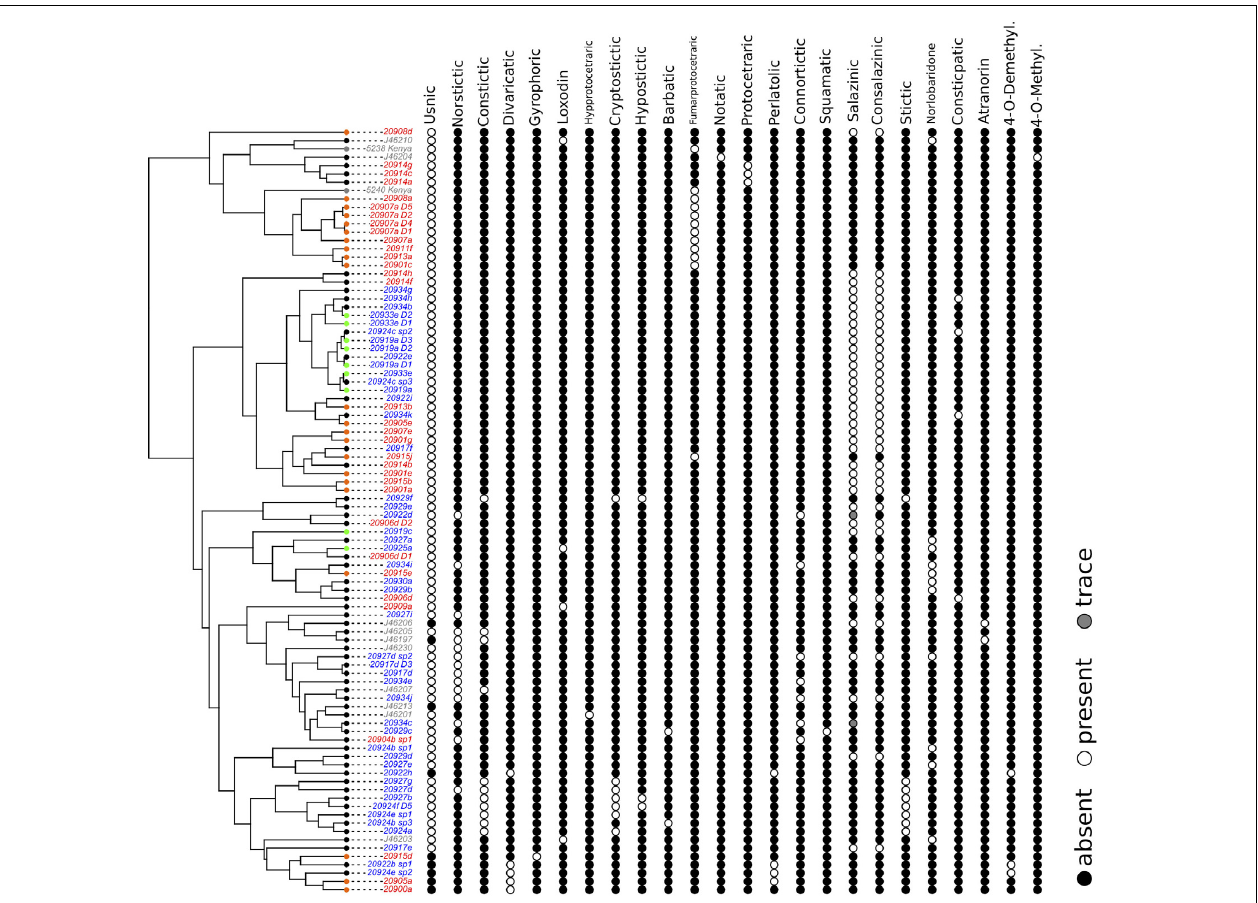
FIGURE 3 | The presence and absence of 24 tested chemical substances for each examined sample in our study (one of the substance was invariably absent in all the samples and was not shown in the figure – succinprotocetraric). Different colors of the tips of the phylogeny depict their substrate types, while colors of the specimen names depict the geographic origins (see Figures 1 , 2 for